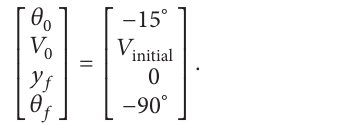
Table 1: The optimal initial position in different velocities for maximum impact